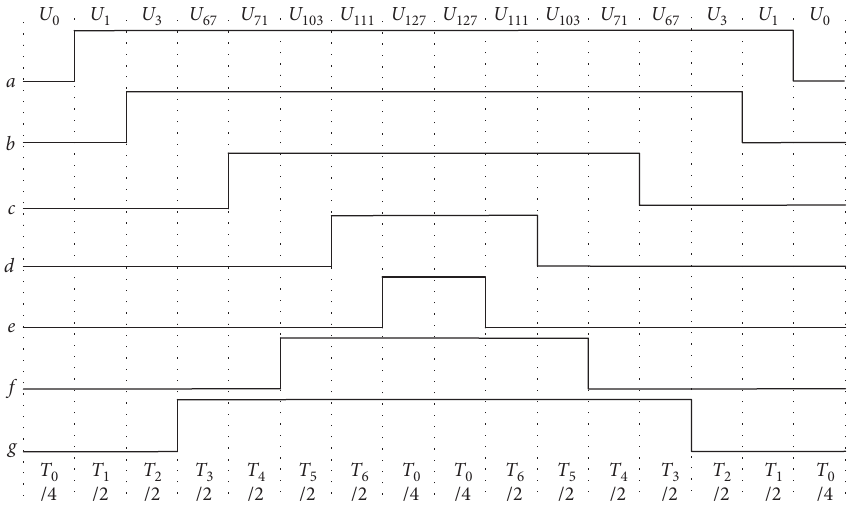
Figure 6: Switching signal of NSV-SVPWM algorithm in sector